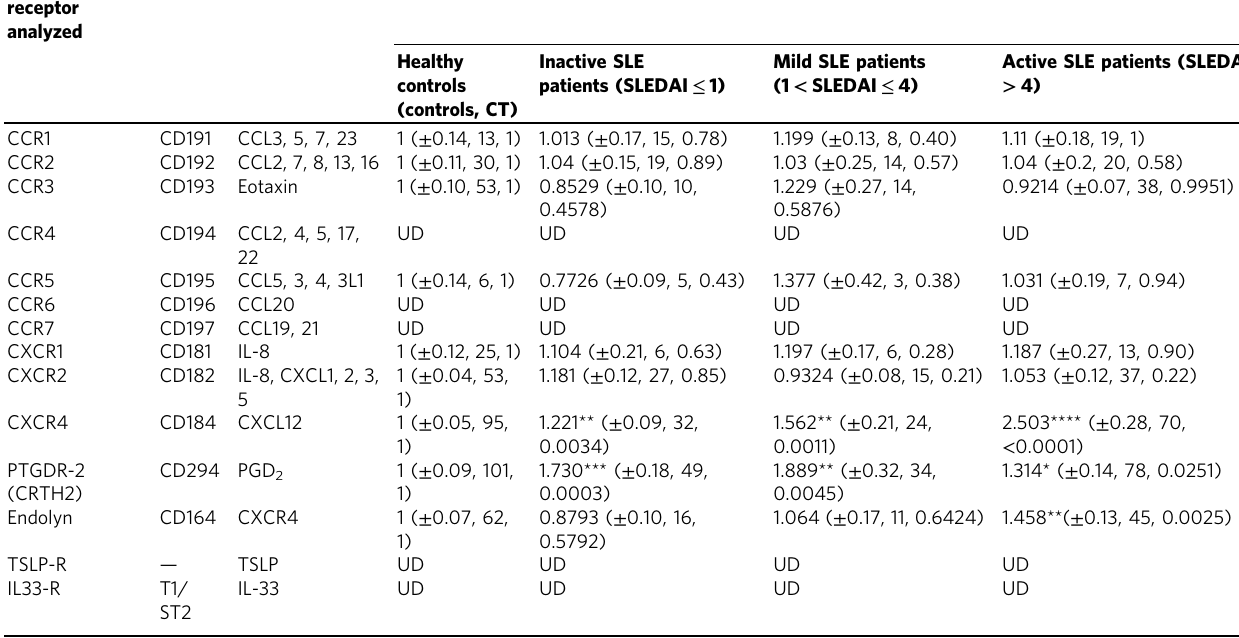
Table 1 Basophil surface marker expression relative to SLE disease activity CD # Normalized expression levels (to CT mean) on basophils from: Mean ( ± SE, n , P Mann − Whitney test Chemokine or vs cytokine receptor analyzed